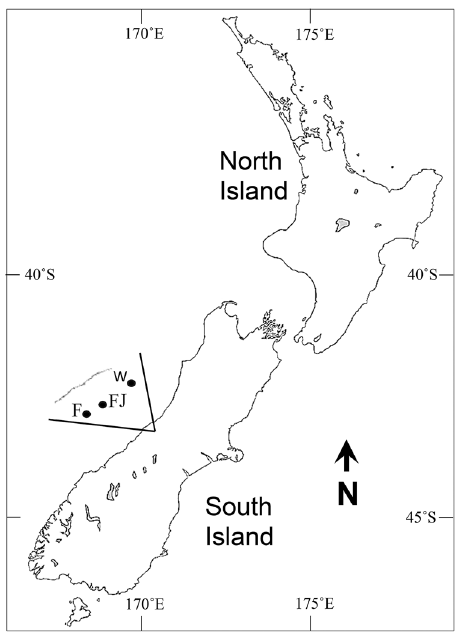
Figure 1. Localities of New Zealand glacier field sites. Collections were made on April 28, 2020, along a NE SW transect spanning ~ 35 km, from Whataroa (W; − 43.4002, 170.5231; 4,859 ft) to Franz Joseph (FJ; − 43.6575, 170.2374; 6,890 ft) to Fox (F; − 43.5331, 170.1271; 6,483 ft) Glaciers. North is